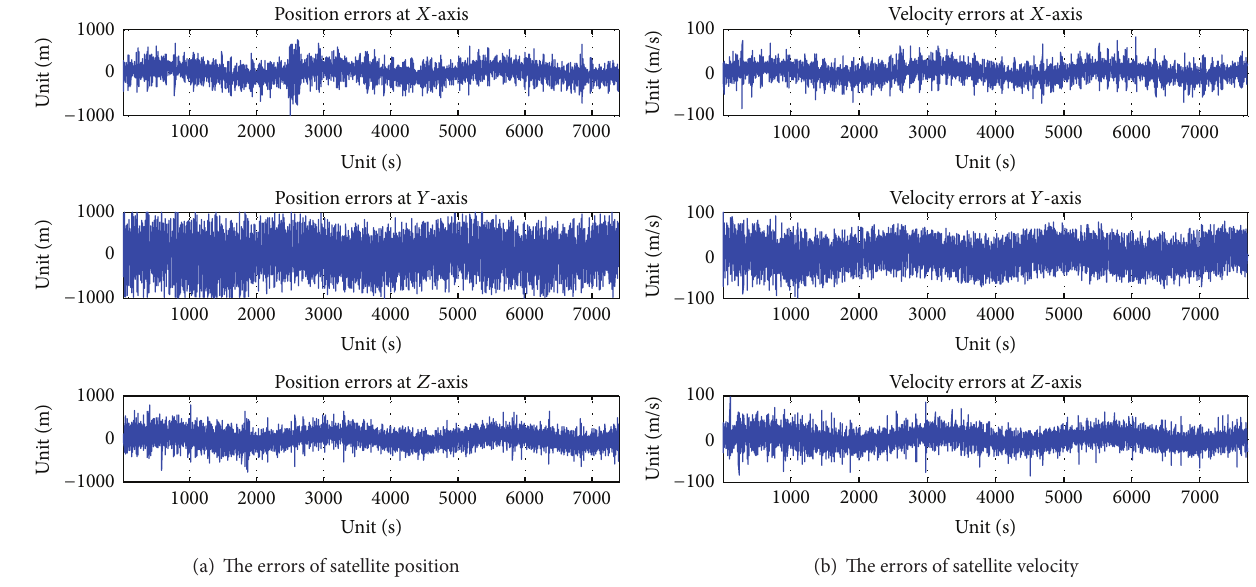
Figure 9: The autonomous result with a sensor that integrated infrared earth sensor and star sensor.